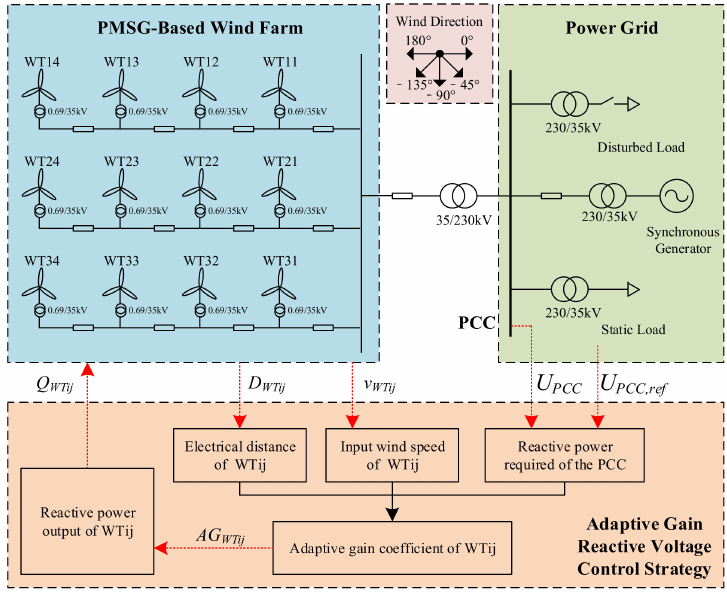
Figure 11. The proposed strategy control block